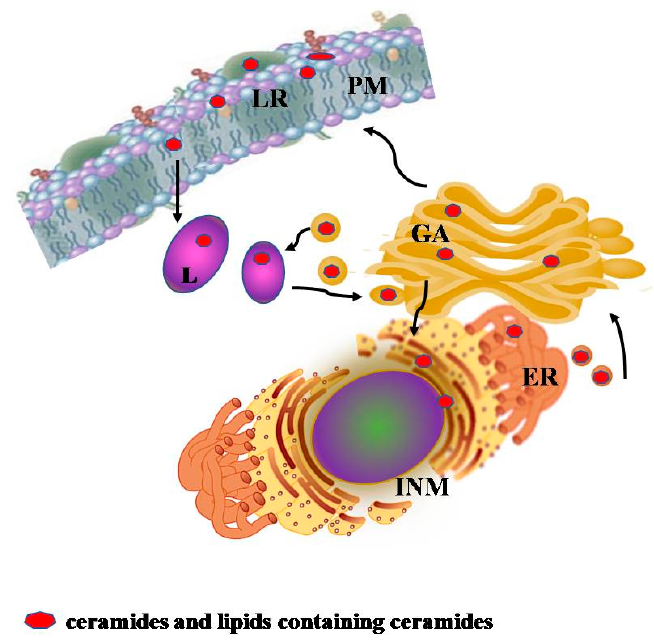
Figure 1. Schematic representation of the interplay between lysosomes and other cellular compartments of ceramides and lipids containing ceramides. Description in the text. ER, endoplasmic reticulum; GA, Golgi apparatus; INM, inner nuclear membrane; L, lysosome; LR, lipid raft; PM, plasma membrane.